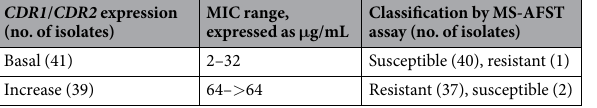
Fig. 2. Overall, growth curves obtained from the isolates in the presence or absence of anidulafungin were super- imposable for both WT and FKS1 -NWT isolates but not for FKS2 -NWT isolates. For these last isolates, two growth profiles could be noticed, of which one very similar to that the FKS1 -NWT isolates and another quite dif- ferent from that of WT or FKS1 -NWT isolates—thus isolates corresponding to the two profiles were designated as FKS2 -NWT fast and FKS2 -NWT slow , respectively. Next, the cell doubling times of anidulafungin-exposed and unexposed isolates’ cells were compared among groups of FKS1 -NWT or FKS2 -NWT isolates (Fig. 2). Overall, no statistically significant differences in the mean doubling-time values were noticed ( p > 0.05, for all comparisons; paired t-test) (Fig. 2a), whereas the mean